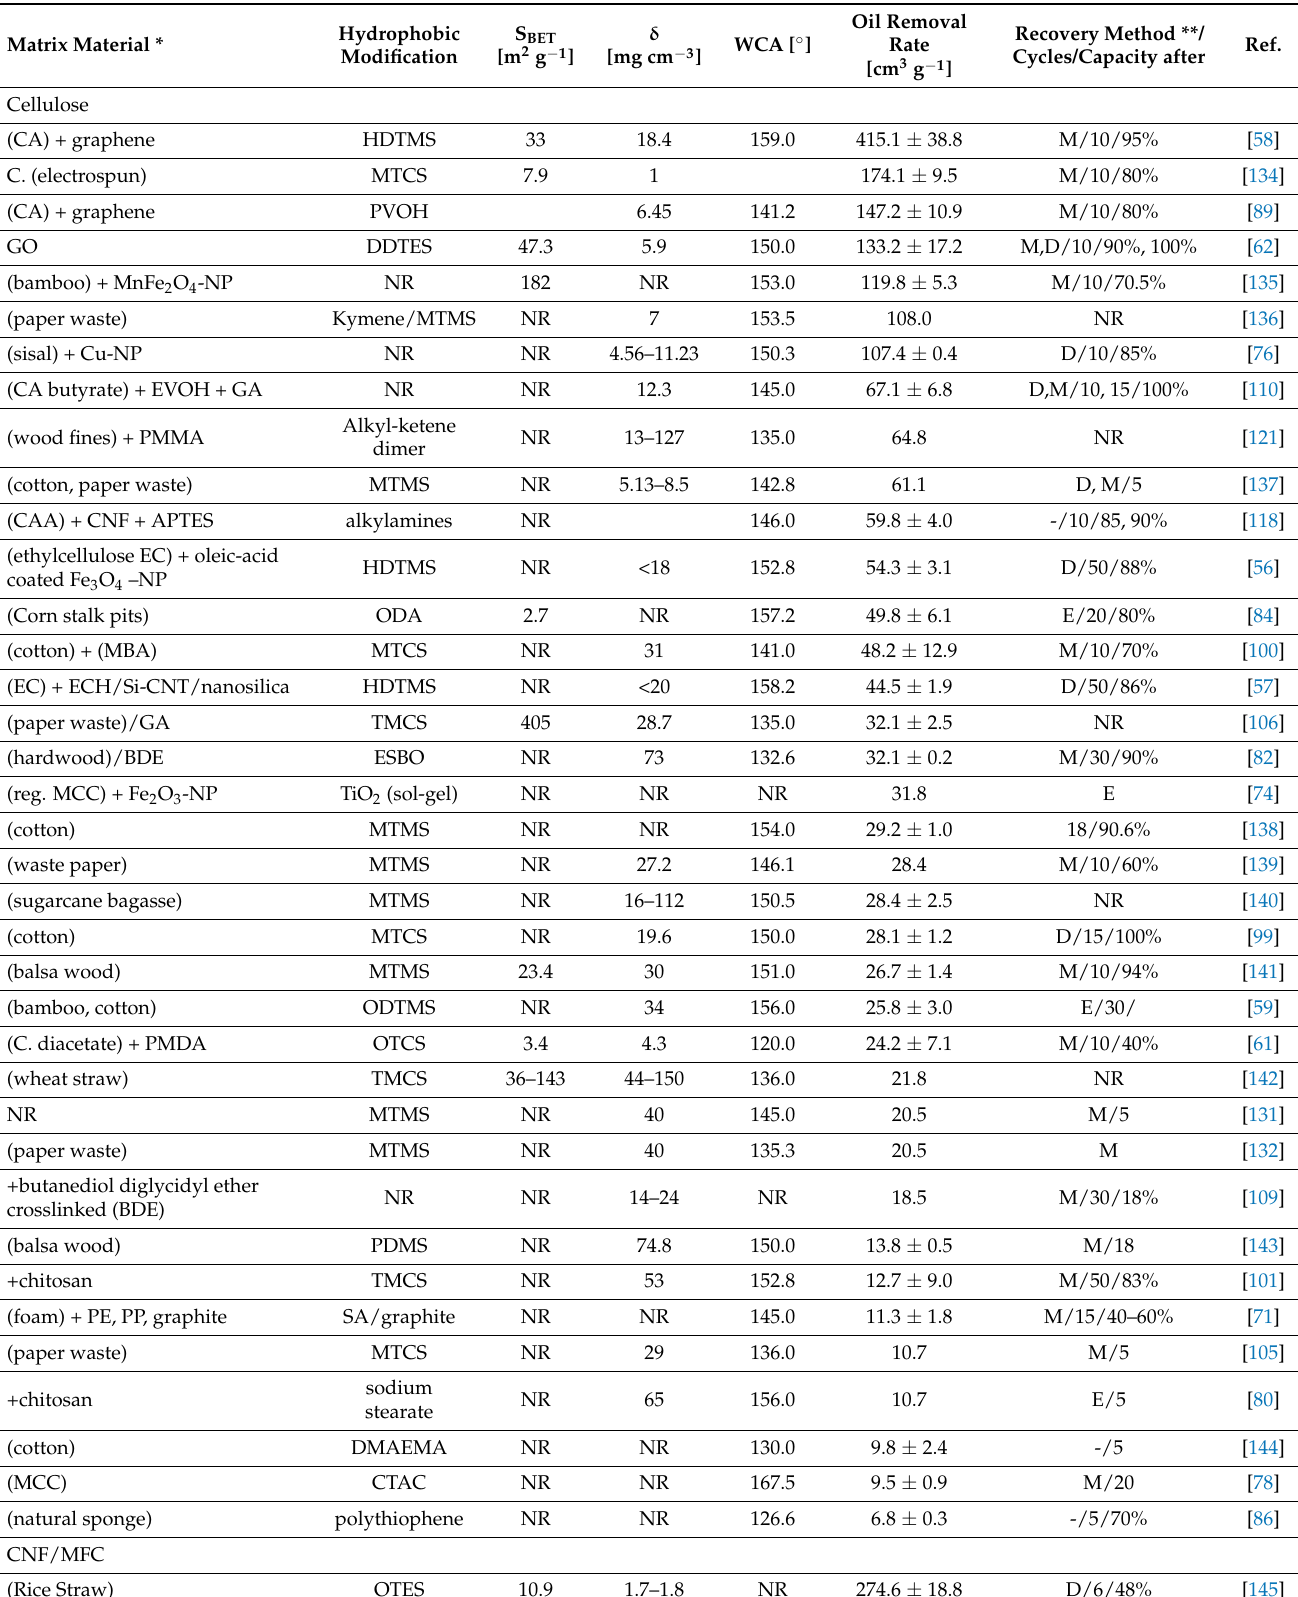
Table 1. Hydrophobic aerogels used for oil